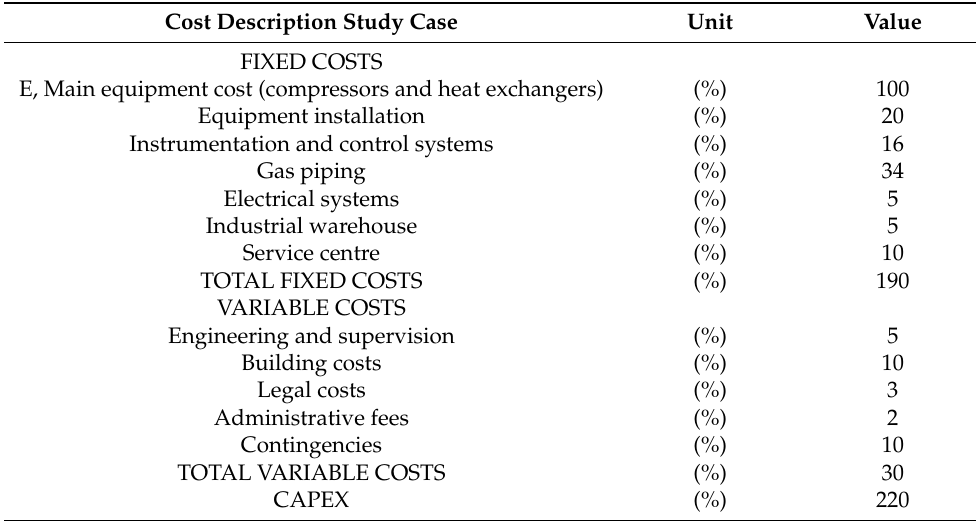
Table 2. Investment estimation based on a percentage of the equipment acquisition